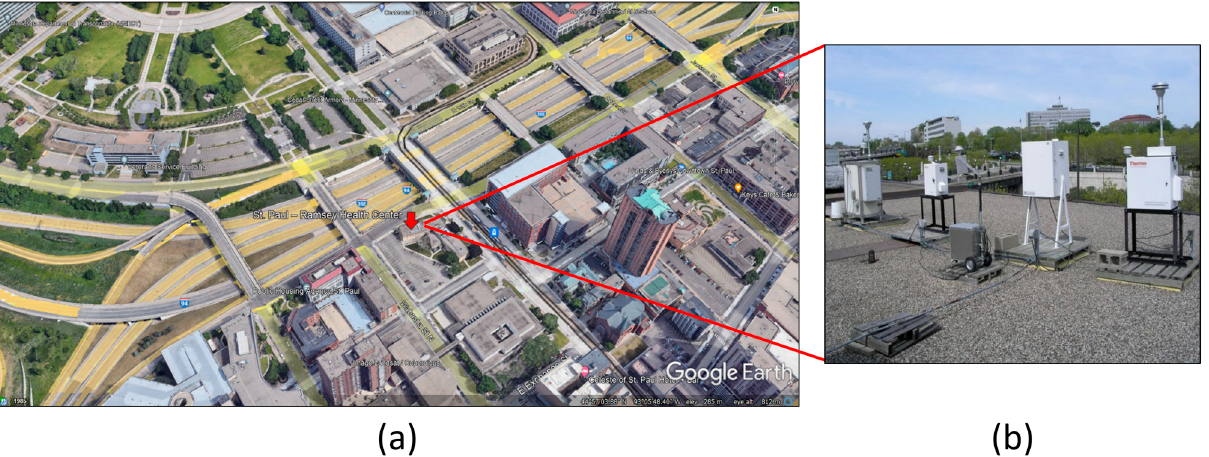
Figure 13. ( a ) Saint Paul—Ramsey Health Center Monitoring Site. Map Data: Google Earth ( b ) Monitoring Equipment. Photo: Minnesota Pollution Control Agency.